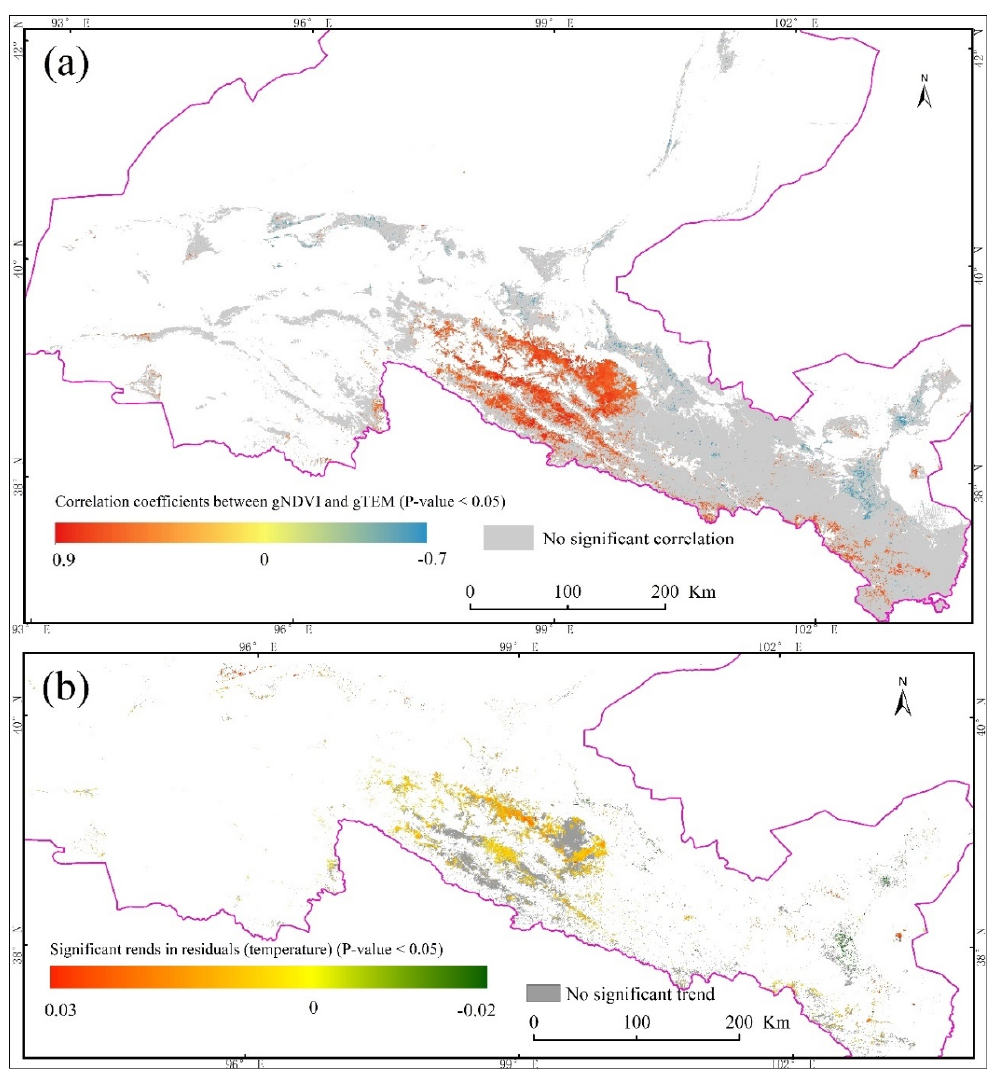
Figure 8. Correlation coefficients between gNDVI and gTEMP in the Hexi region over the period 2001−2017 ( a ) and trends in residuals derived from the linear regressions between gNDVI and gTEMP ( b ).